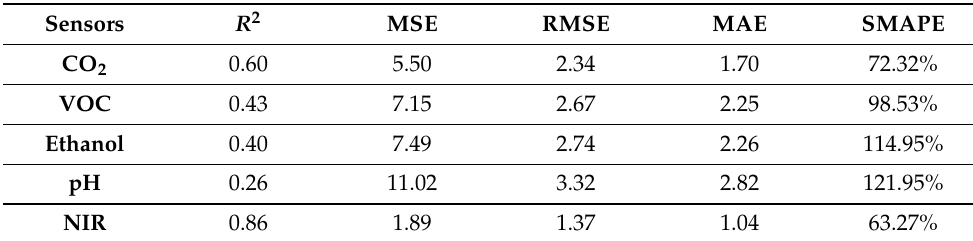
Table 4. Performance Metrics Benchmark Linear